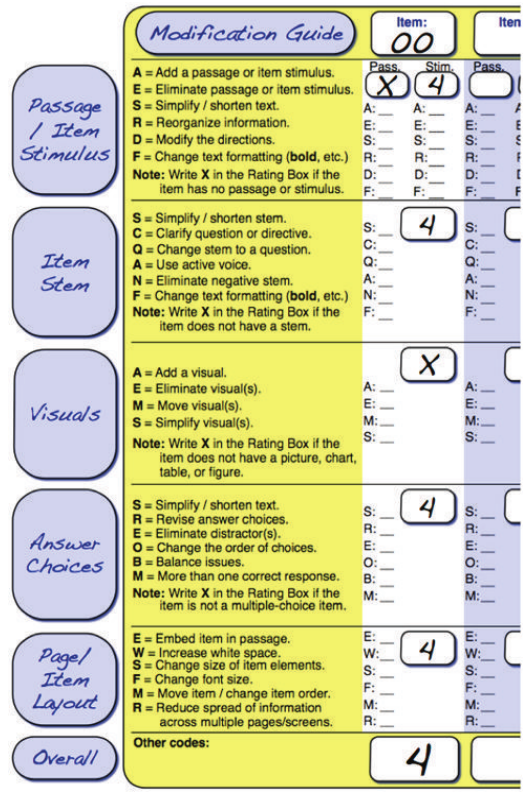
Figure 3: Grade 10 science item with ARM